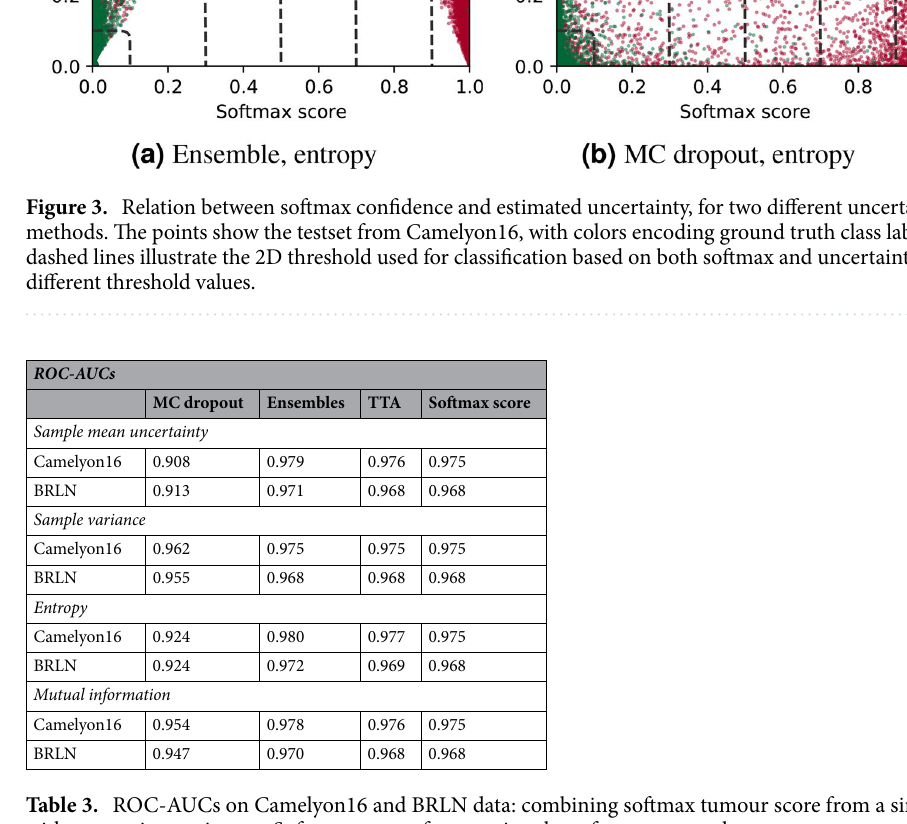
Table 3 summarises the ROC-AUC results on Camelyon16 and BRLN data, for different combinations of uncertainty metrics and methods. We can see that MC dropout is the only method that, independently of metric